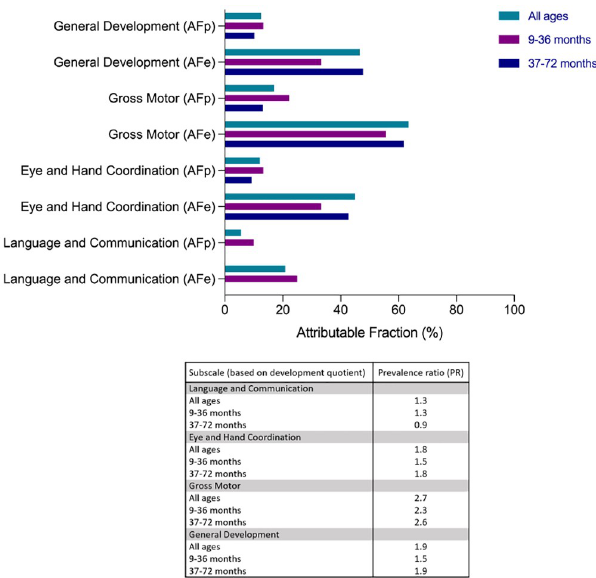
Fig 6. Estimated proportion of poor cognitive performance (based on development quotient) attributable to stunting. AFe = Attributable fraction in the stunted population, AFp = attributable fraction in the total population. Attributable fractions were estimated for indices with PR >